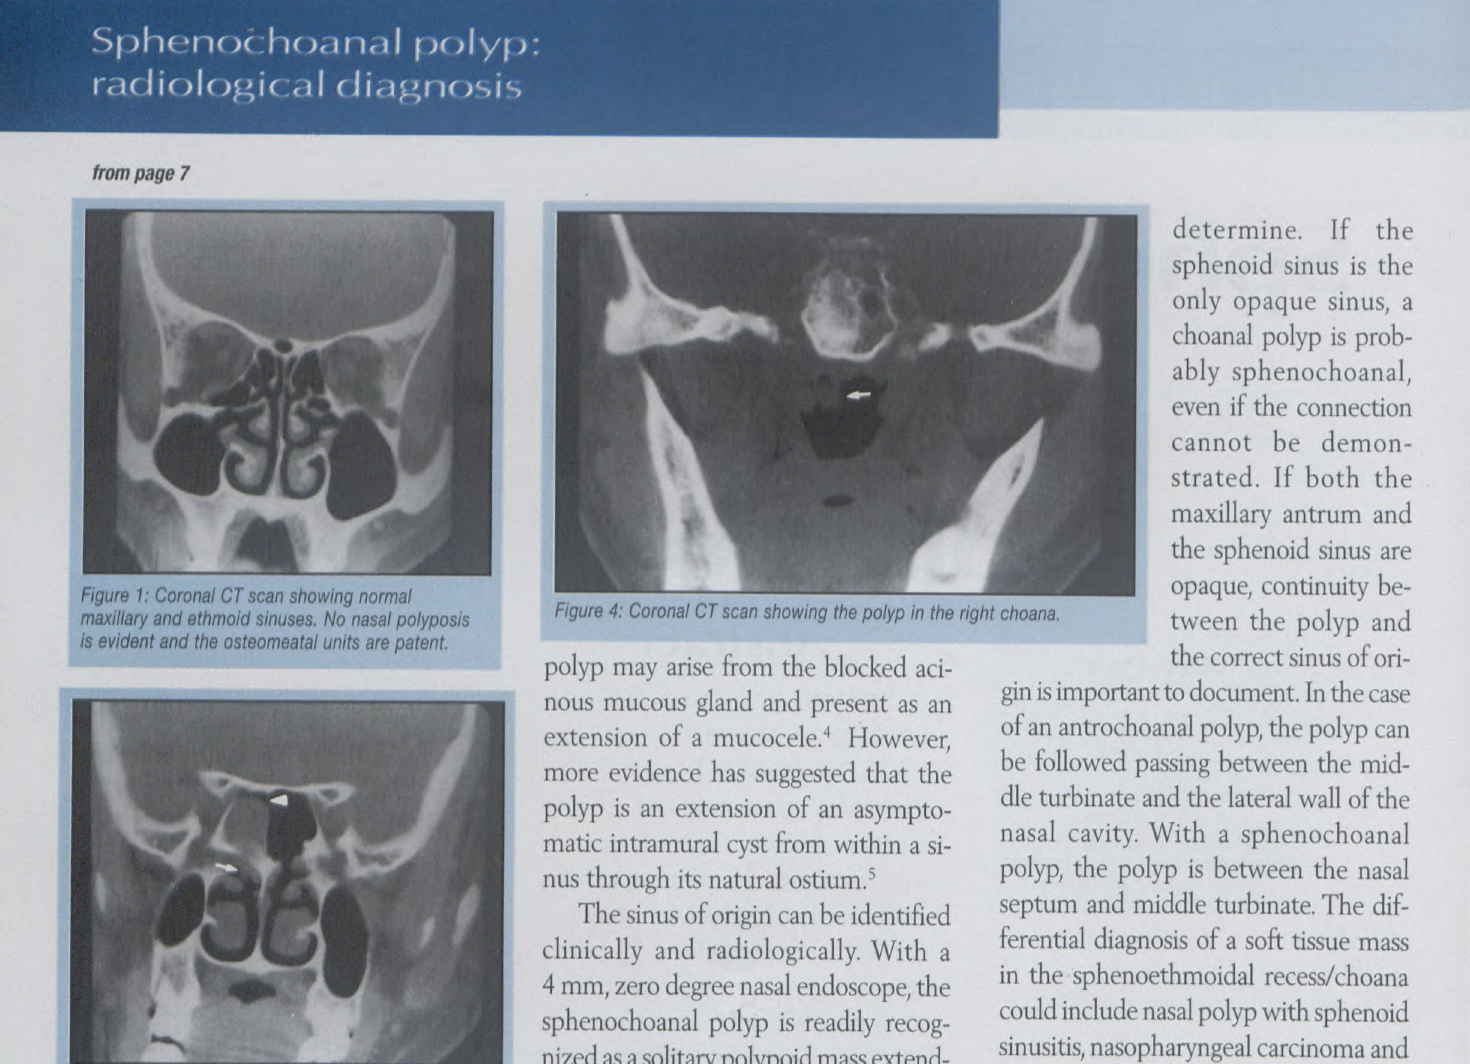
Figure 4: Coronal CT scan showing the polyp in the right choana.